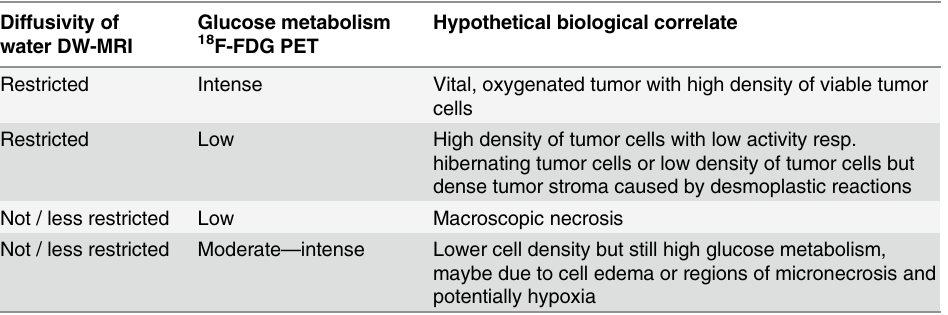
Table 1. Relationship between the degree of water diffusivity and glucose metabolism, and their potential biological